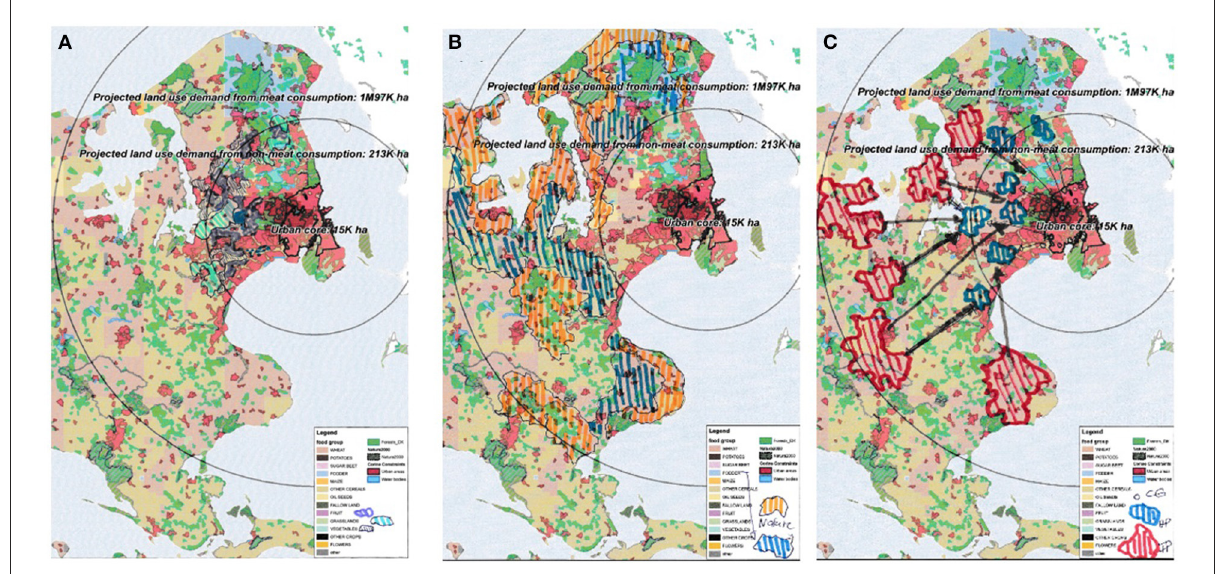
FIGURE9 Scenarios sketched on paper by the three groups. (A) Plant-based food and recreation (inner ring), (B) Meat-based food and nature (outer ring), and (C) Agroparks as islands of plant-based food (across all